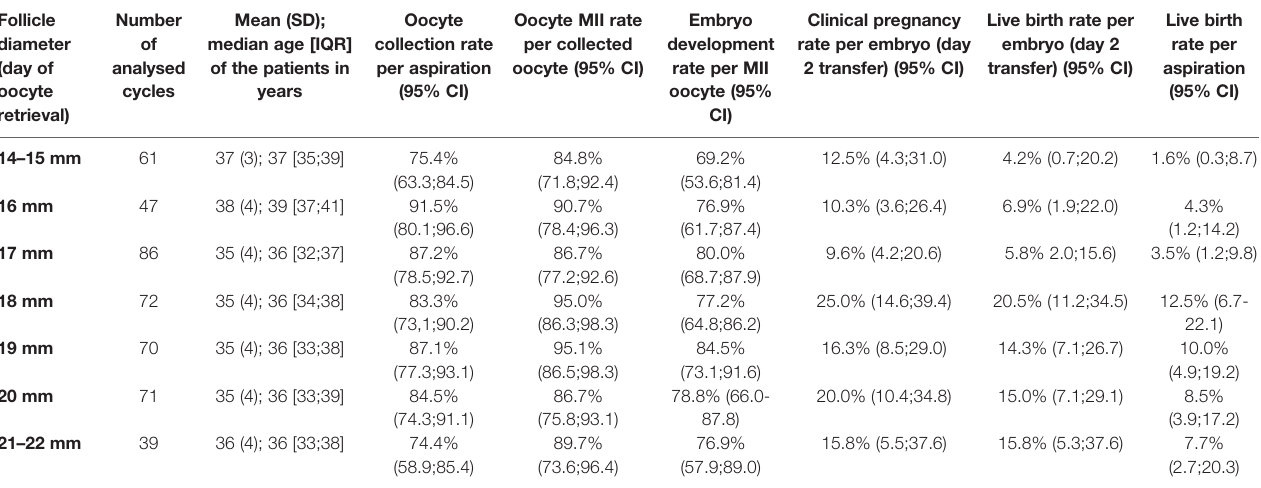
TABLE 4 | Association of outcome parameters with follicle size.